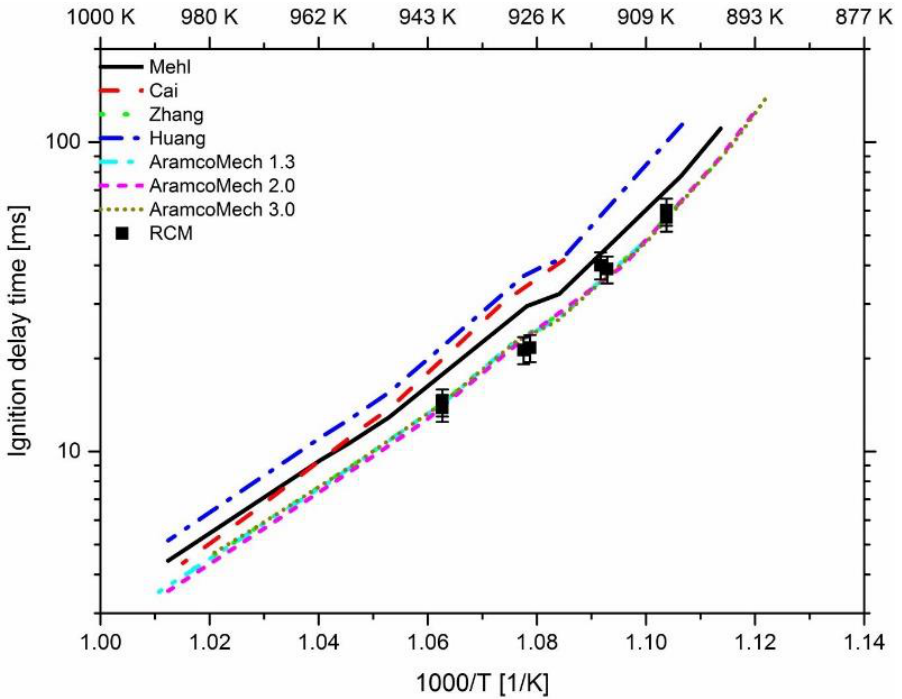
Figure 4. Experimental RCM data (symbols) [37] versus model prediction at P c = 100 bar using 100 mol % CH 4 at λ = 1.9.